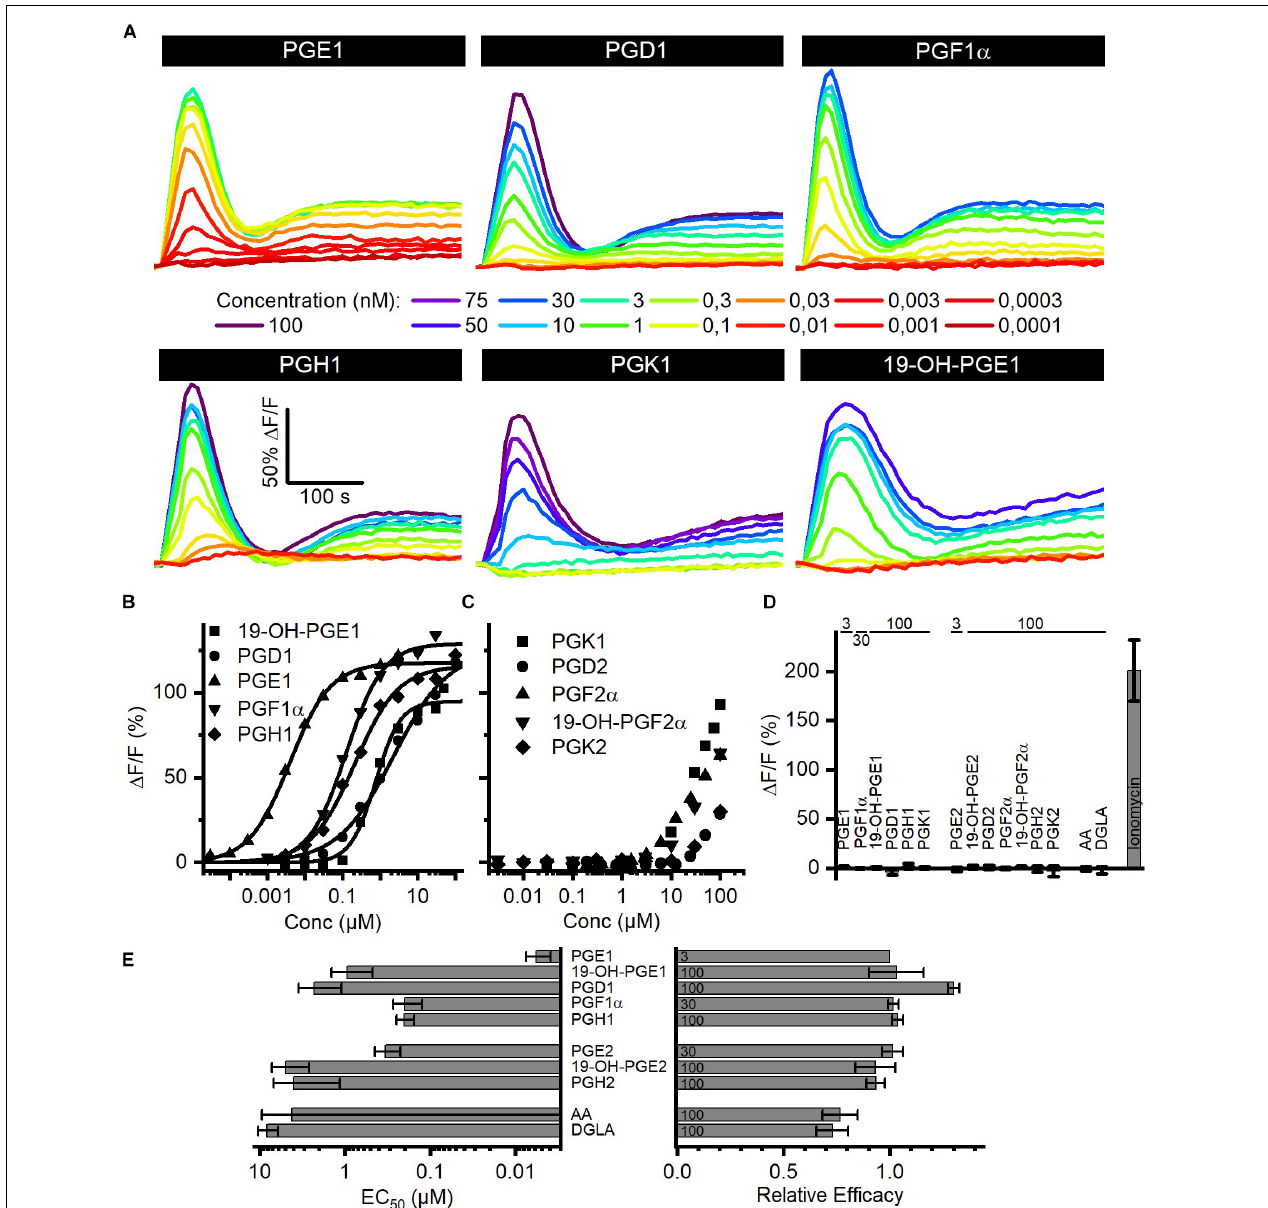
FIGURE 4 | Prostaglandin-evoked Ca 2 + signals in human sperm. (A) Representative Ca 2 + signals evoked by PGE 1 , PGD 1 , PGF 1 α , PGH 1 , or 19-OH-PGE 1 in control sperm from donors. (B) Concentration–response relationship for the maximal amplitudes of Ca 2 + signals shown in (A) , except for PGK 1 . (C) Concentration–response relationship for the maximal amplitudes of Ca 2 + signals evoked by PGK 1 , PGD 2 , PGF 2 α , 19-OH-PGF 2 α , or PGK 2 ; the concentration–response relationships could not be fitted to derive an EC 50 , because the signal amplitudes did not saturate at the highest concentration tested. (D) Mean ( ± SD) maximal amplitude of Ca 2 + signals evoked by prostaglandins (at the concentration indicated in µ M) or the Ca 2 + -ionophore ionomycin (2 µ M) in CATSPER2 - / - sperm ( n = 3–5). (E) Left: potency, i.e., mean ( ± SD) EC 50 ( n = 3–4), of prostaglandins to evoke Ca 2 + signals in control sperm; right: relative efficacy of prostaglandins to evoke Ca 2 + signals in control sperm, i.e., mean ( ± SD) maximal signal amplitude evoked by the respective prostaglandin at the indicated saturating concentration (in µ M) relative to that evoked by PGE 1 (set to 1) ( n =